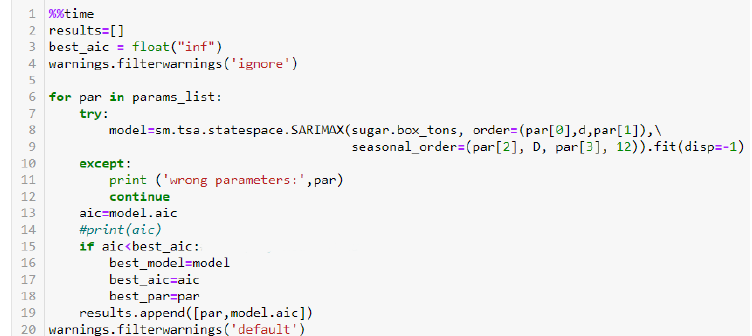
Figure 10. Application of the Akaike information criterion.